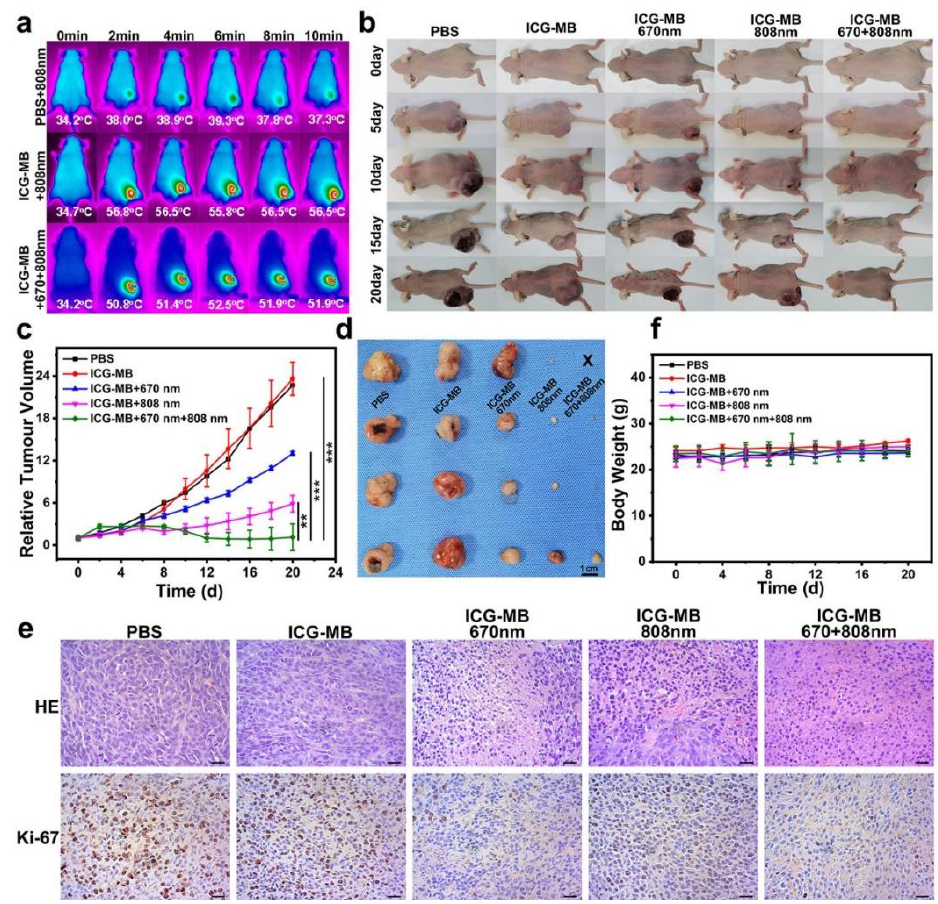
Figure 7. ( a ) In vivo thermal imaging of mice after treatment with ICG-MB upon laser irradiation. ( b ) Representative photos of mice after being injected with PBS, ICG-MB, then subjected to laser irradiation. ( c ) Tumor volume curve of mice in different groups. ( d ) Representative photos of tumors in different groups (** p < 0.01, and *** p < 0.001). ( e ) H&E and Ki-67 staining of tumor slides from mice in different groups. Scale bar: 50 μm. ( f ) The changes in body weights of mice in differ- ent groups.